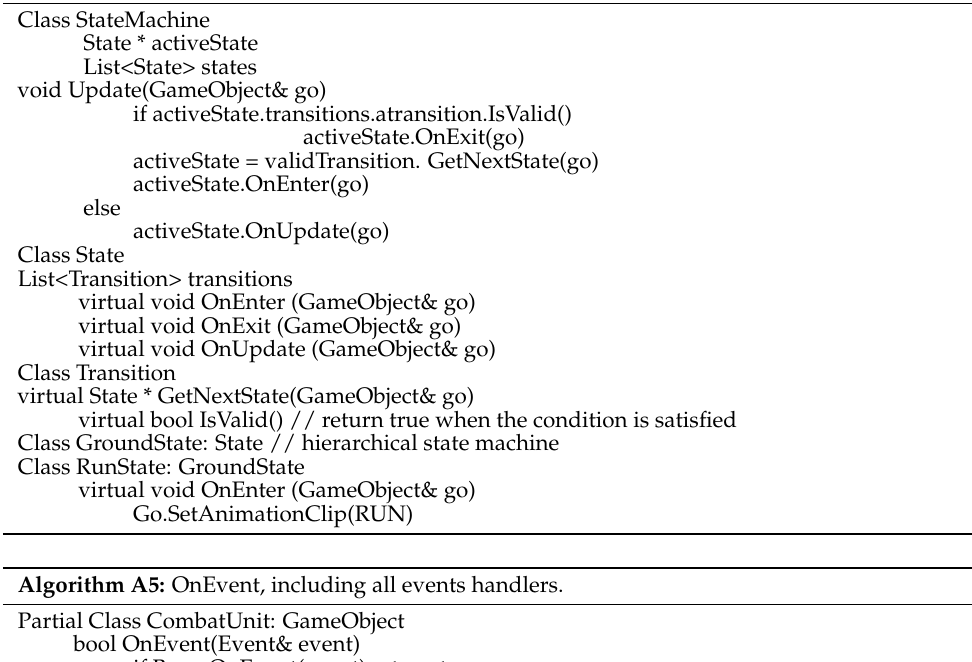
Algorithm A4: The animation state